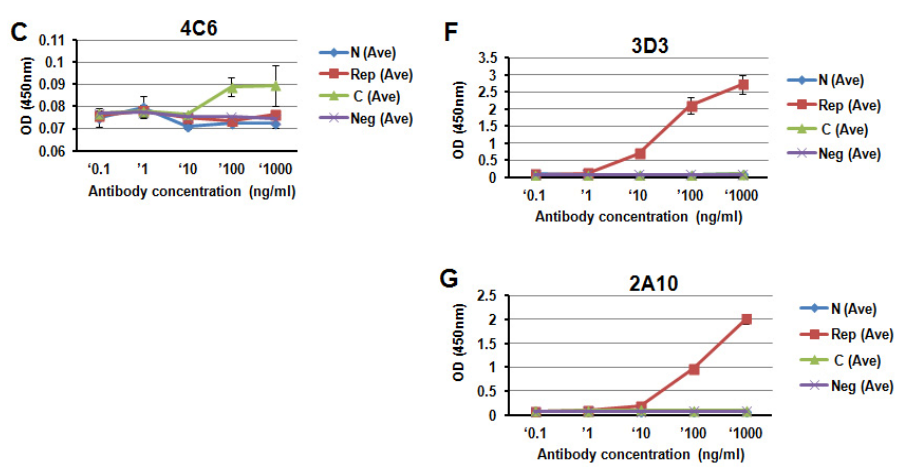
Figure 2. Specificity of anti ‐ PfCSP monoclonal antibodies (mAbs) by enzyme ‐ linked immunosorbent assay (ELISA). Peptides representing PfCSP N ‐ terminal, central repeat, and C ‐ terminal regions were used to evaluate specificity of anti ‐ PfCSP mAbs (Table 1). (A) , 2D4; (B) , 4C1; (C) ,4C6; (D) , 3C1; (E) , 3C2; (F) , 3D3; (G) , 2A10. The mAb 2A10 was used as a positive control. ELISA was performed in duplicate. Data are representative of three independent experiments. OD, Optical density.